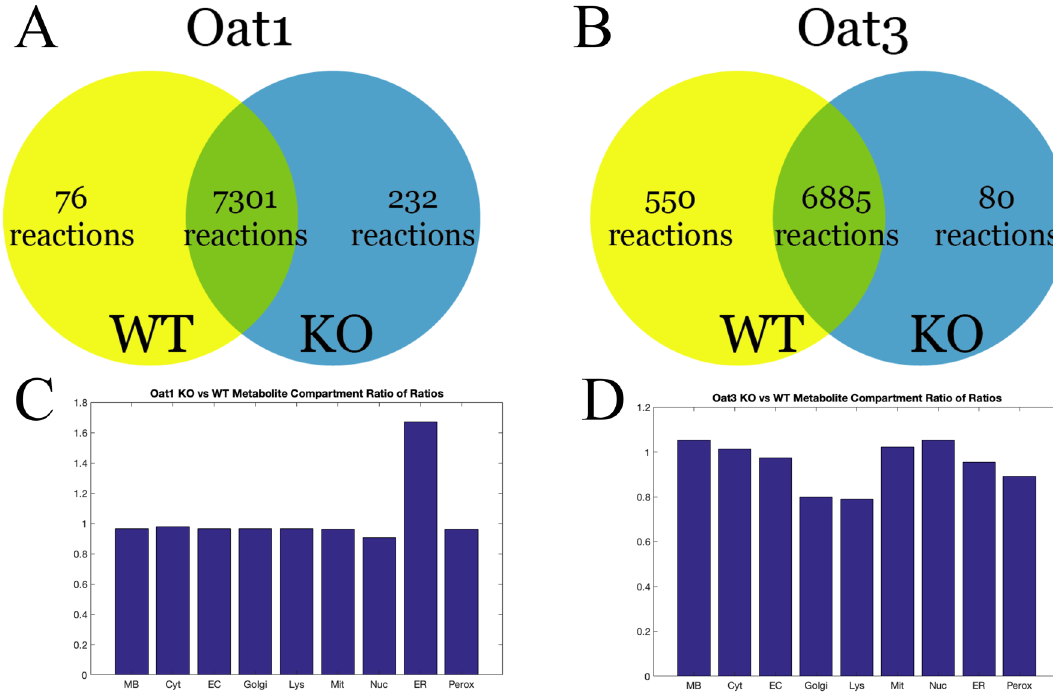
Figure 3. Comparison of metabolic reactions and organelle metabolite content between WT and OAT1 and OAT3 KO mice. Comparison between the renal transcriptome-constrained models revealed overlap between the WT and KO, as expected, but it is important to note there exist notable differences. In particular, there are metabolic reactions that are “unique” or specific to the WT but not to one or both knockouts, and vice- versa. These differences are manifest in part by the organelle-specific metabolite composition changes (e.g. endoplasmic reticulum) in the KO mice reconstructions. The organelle-based differences reflecting different pathways of metabolism are noted in OAT1 versus OAT3. ( A ) OAT1 WT and KO Venn diagram summary of the kidney/microbiome model. The relatively larger number of unique KO model reactions suggests that in order to compensate for the loss of OAT1, the kidney cells must rely on a larger set of reactions associated with certain organelles. ( B ) OAT3 WT and KO Venn diagram summary of the kidney/microbiome model. ( C ) Ratio of the relative number of unique metabolites in OAT1 KO versus WT models across all 9 compartments. There is a significant increase in the number of metabolites in the endoplasmic reticulum (Chi-square p < 0.001) of the knockouts; these largely reflect the 232 unique knockout model reactions. ( D ) Ratio of the relative number of unique metabolites in OAT3 KO versus WT models across all 9 compartments. In contrast to the OAT1 WT versus KO, the OAT3 KO has a significantly lower number of metabolites (Chi-square p < 0.01) in several compartments, namely the Golgi apparatus, lysosome, and peroxisome; these changes are also consistent with the relatively larger number of unique reactions in the WT model ( B ). MB microbiome, Cyt cytosol, EC extracellular, Gol Golgi, Lys lysosome, Mit mitochondria, Nuc nucleus, ER endoplasmic reticulum, Perox